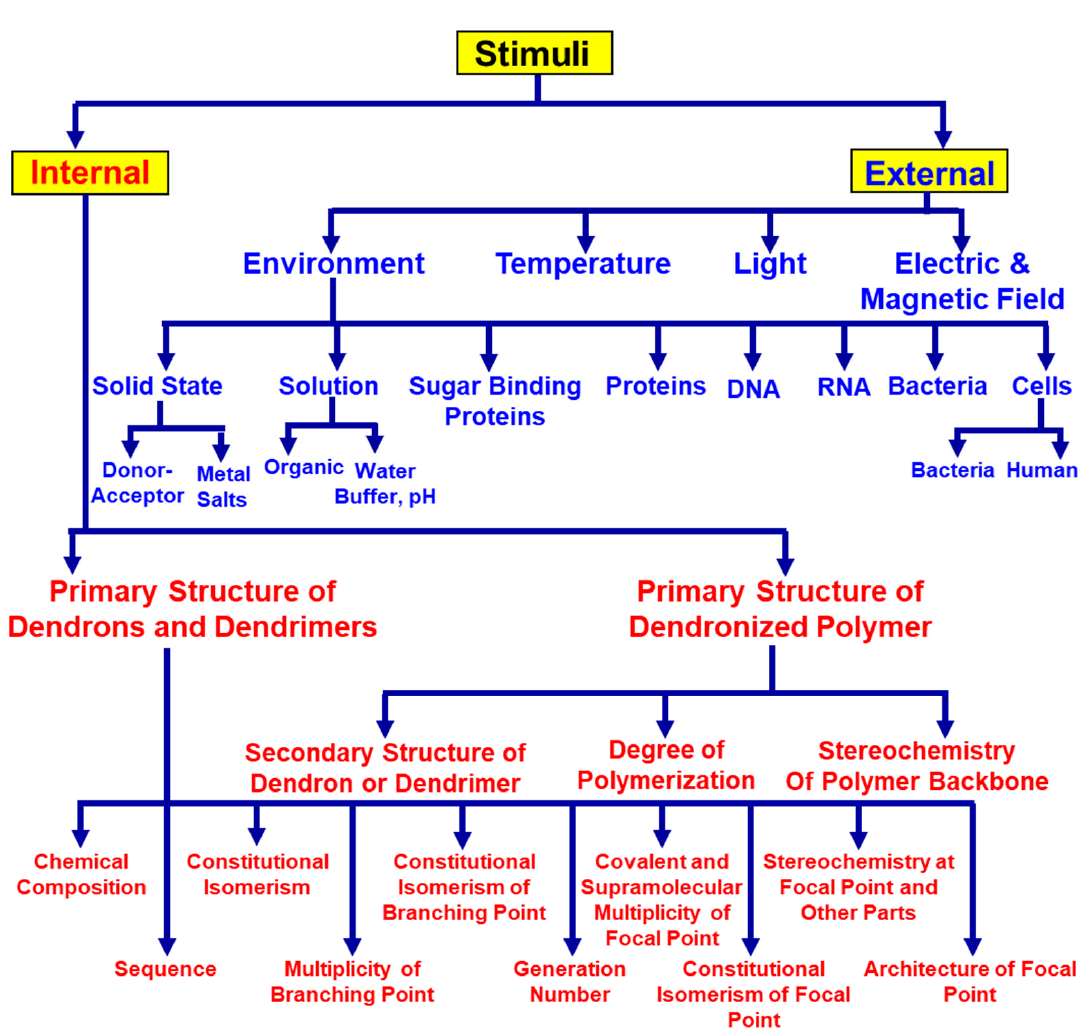
Figure 6. The classifications of internal- and external-stimuli in self-organized dendrimers generated from self-assembling and self-organizable dendrons, dendrimers, and dendronized polymers. 7. Internal Stimuli of Supramolecular Dendrimers. Primary Structure of Dendrons